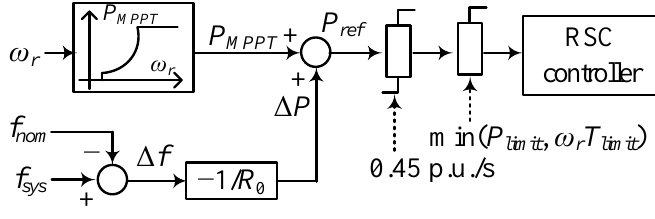
Figure 3. Conventional power-smoothing scheme in [12].